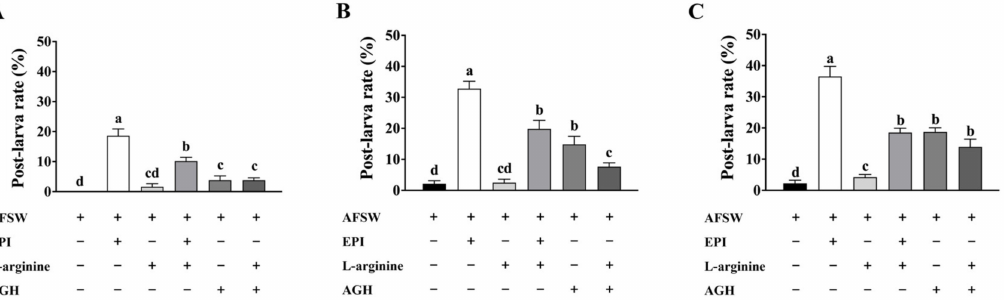
Figure 4. The larval metamorphosis rate on exposure to L-arginine and AGH. ( A ) Larvae exposed to L-arginine and AGH for 48 h, ( B ) 72 h, and ( C ) 96 h. Values represent mean ± SEM ( n = 120), and bars with different letters indicate significant differences ( p < 0.05).